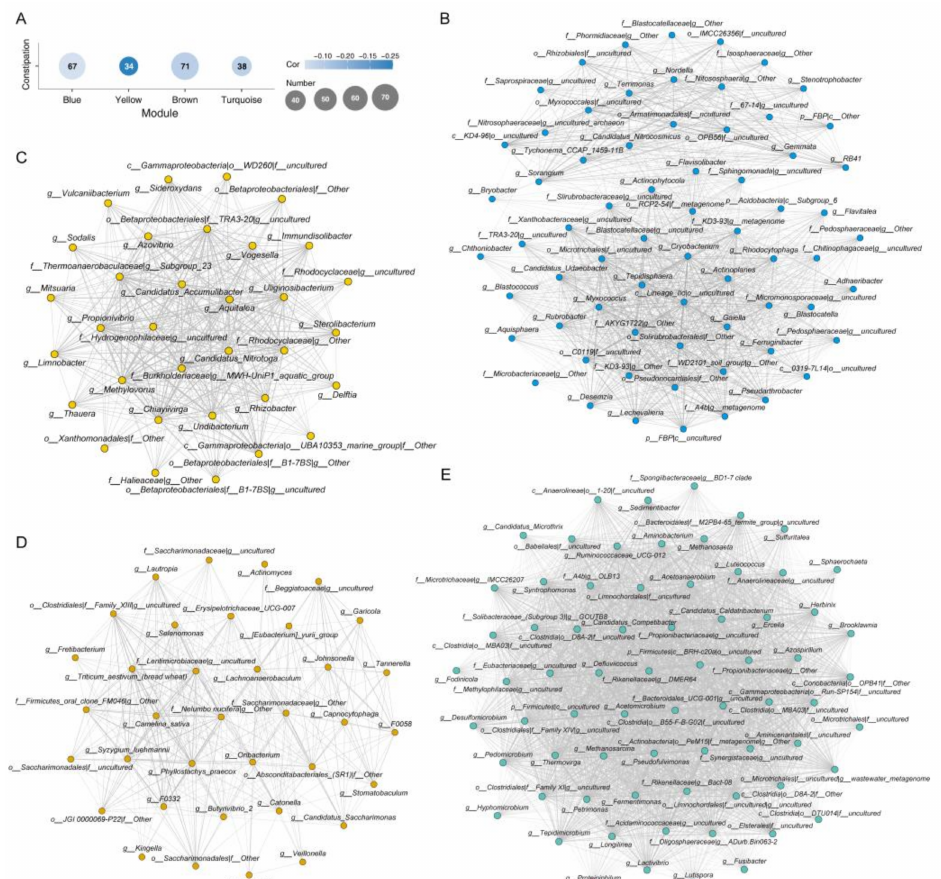
Figure 5. The number of genera and Kendall correlation of clustered modules ( A ). The network modules significantly related to constipation and highly interaction genera were indicated. The cluster of Blue ( B ), Yellow ( C ), Brown ( D ) and Turquoise ( E ).